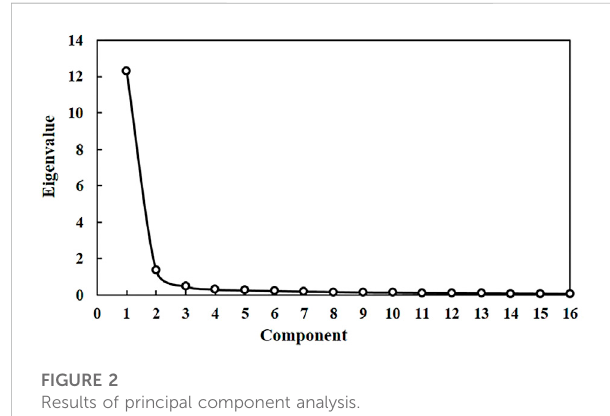
FIGURE 2 Results of principal component analysis.